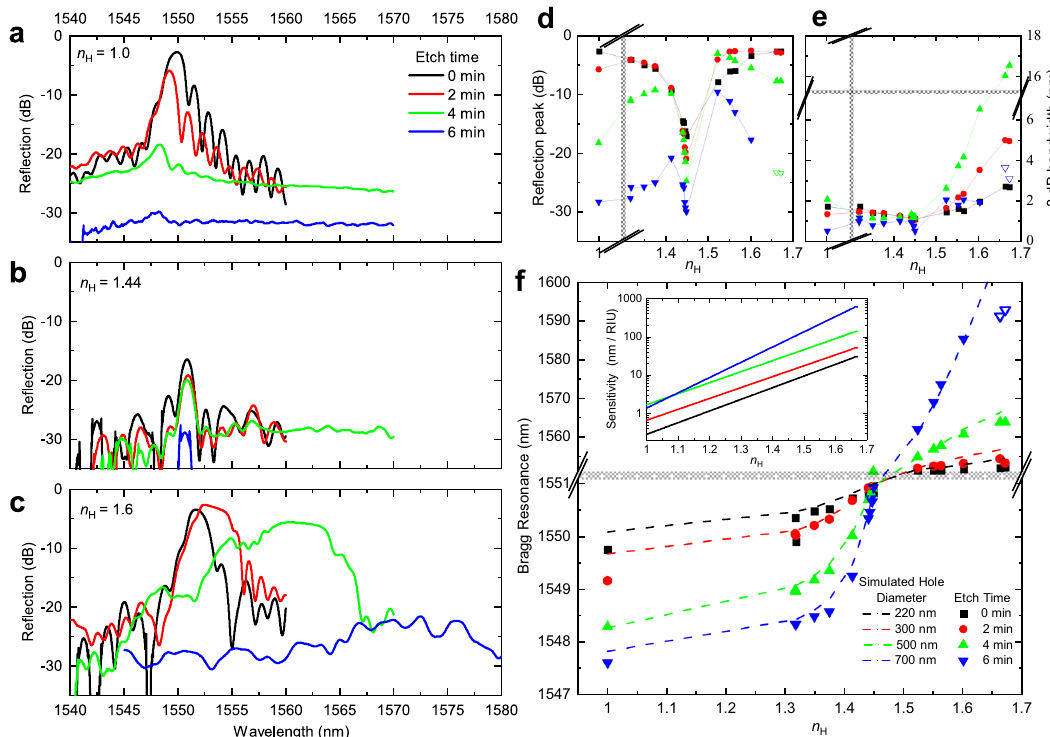
Fig. 5 High-resolution RI sensing enabled by FBGs with different hole diameters. Re fl ection spectra recorded from uniform FBGs ( E pulse = 4.5 µ J, Ʌ = 1072 nm, 600 holes) fi lled with low ( a n = 1), medium ( b n = 1.44), and high ( c n = 1.661) refractive index materials, revealing the in fl uence of H H H increasing nanohole diameter due to varying chemical etching time (0 – 6 min). Peak re fl ection strength ( d ) and 3-dB linewidth ( e ) of the Bragg resonances plotted as a function of refractive index for different chemical etching times (following legend a ). Bragg resonance wavelength (shifts on right axis) plotted versus refractive index f for different chemical etching times. A global fi t of the data by EME simulation is presented (dashed lines) for hole diameters of 220 – 700 nm (see legend). The slopes of data provide a strongly increasing refractive index sensitivity (inset) for increasing RI and increasing hole diameter (colour-coded lines). Shaded zones mark axis scale